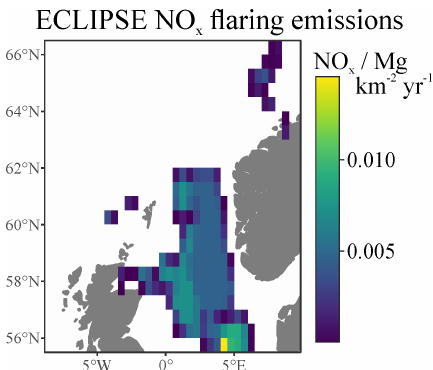
Figure D2. ECLIPSE v5 NO x flaring emissions over the North Sea, at 0 . 5 ◦ × 0 . 5 ◦ for 2020 (Stohl et al., 2015).